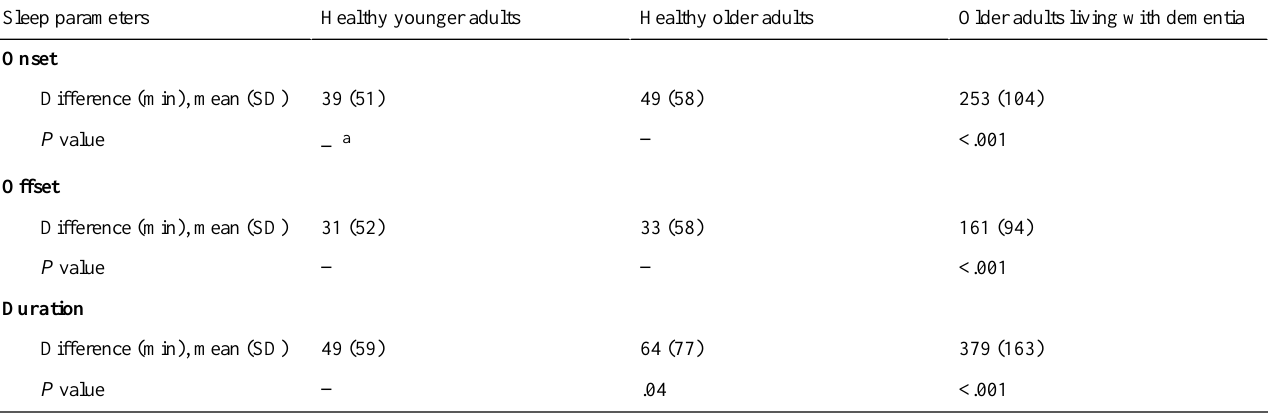
Table 3. The absolute difference of sleep parameters between (recreated) sleep journals and the Mi Band 2 for each group.